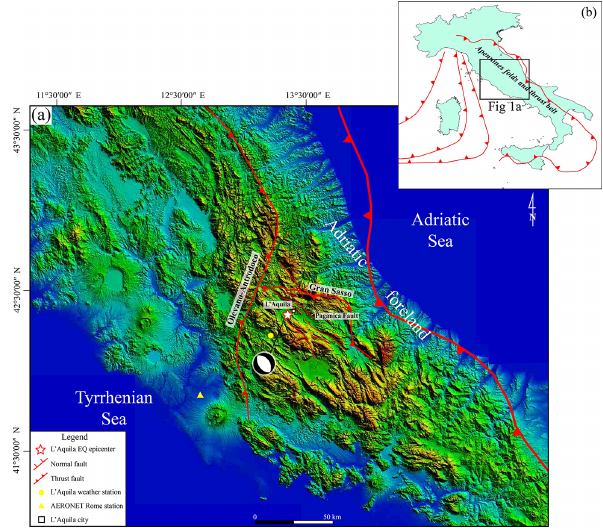
Figure 1. Simplified tectonic and topographic map of central Italy. (a) Digital elevation model from the Shuttle Radar Topography Mis- sion (SRTM) data showing the epicenter of the 2009 L’Aquila earth- quake (white star) along with its focal mechanism solution (FMS). The FMS was obtained from the U.S. Geological Survey’s National Earthquake Information Center (Di Luccio et al., 2010; Piroddi et al., 2014). (b) The main thrusts in Italy, with the black solid line box showing the geographical location of (a) (Benoit et al.,